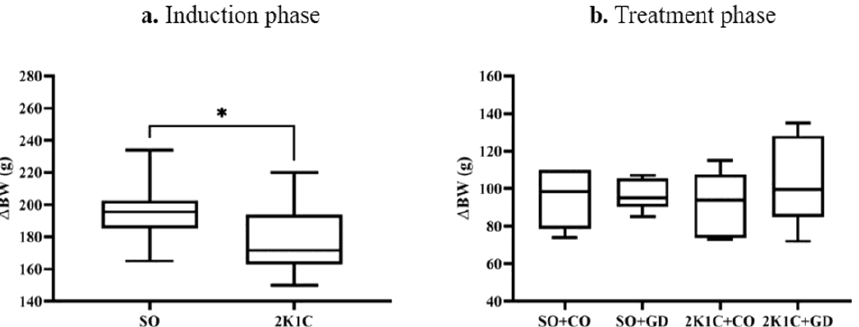
Figure 2. Body weight changes ( ∆ BW, g) in the sham-operative (SO) and 2K1C groups during the hypertension induction phase ( a ) and during the treatment phase with GD flower extract ( b ). Data are expressed as mean ± S.E.M. * p < 0.05 between groups.